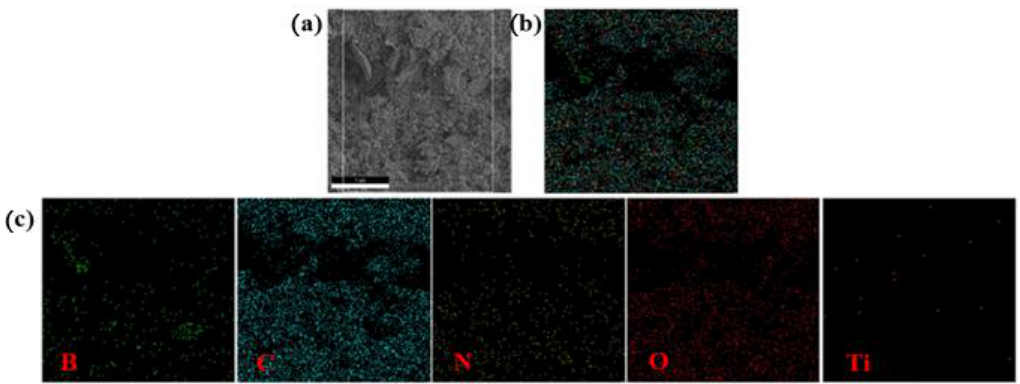
Figure 8. ( a ) An SEM photo of the material; ( b ) the element distribution map; and ( c ) EDS elemental mapping consisting of B, C, N, O, and Ti. Table 1. The elemental content of the B 4 C/TiO 2 /polyimide molded plate cross-section. Element